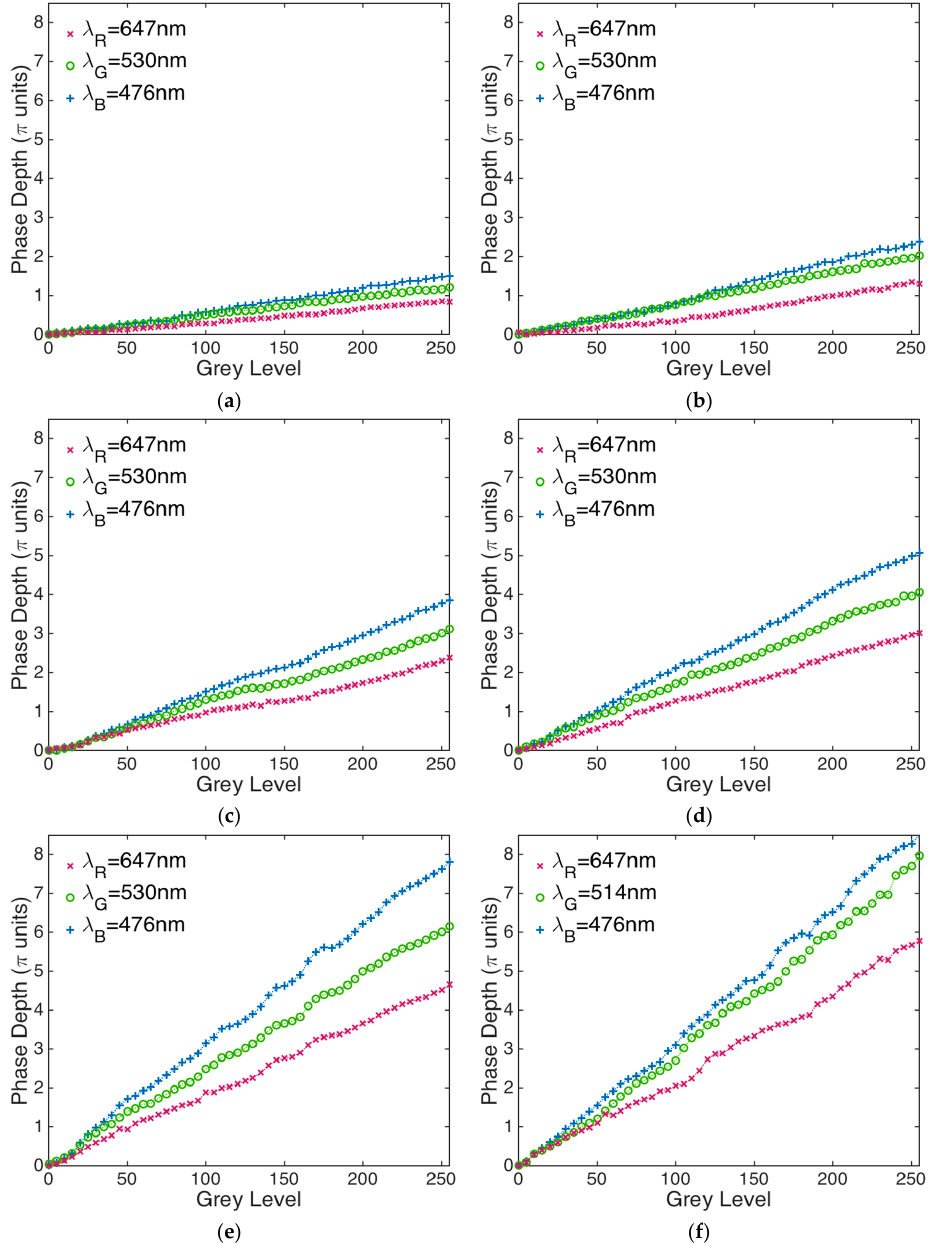
Figure 6. Phase modulation responses of the LCoS display for three di ff erent wavelengths ( λ R = 647 nm, = 530 nm, and λ = 476 nm). The calibration curves were optimized for λ λ G B phase modulation ranges: ( a ) 1 π ; ( b ) 2 π ; ( c ) 3 π ; ( d ) 4 π ; and ( e ) 6 π while using the more stable SLM 5-5 bit-plane configuration. Note that the calibration curve for 8 π phase modulation ( f ) was originally optimized for λ G = 514 nm using the SLM 18-6 bit-plane